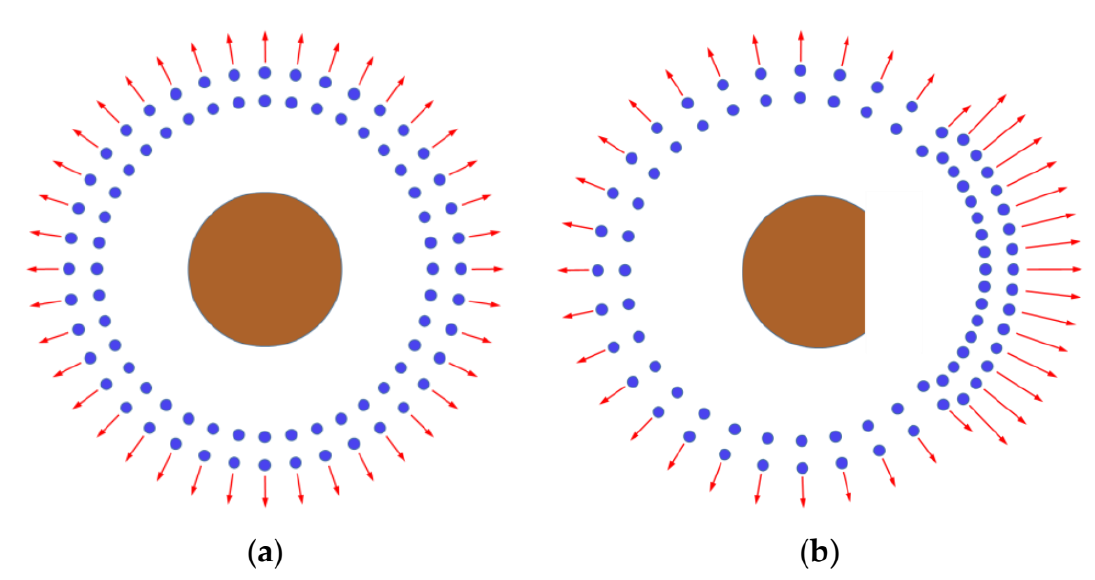
Figure 9. Schematic diagram of the spatial distribution and velocity distribution of fragments corresponding to the cylindrical fragment generator and the D-shaped fragment generator after the explosion of the internal explosive. fragment generator.